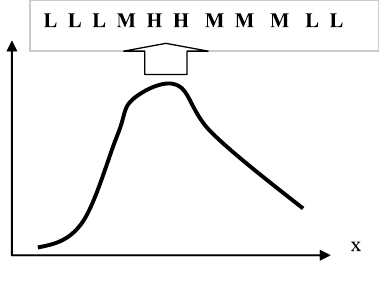
Figure 8. From numeric membership grades to a string of linguistic labels 6.2.